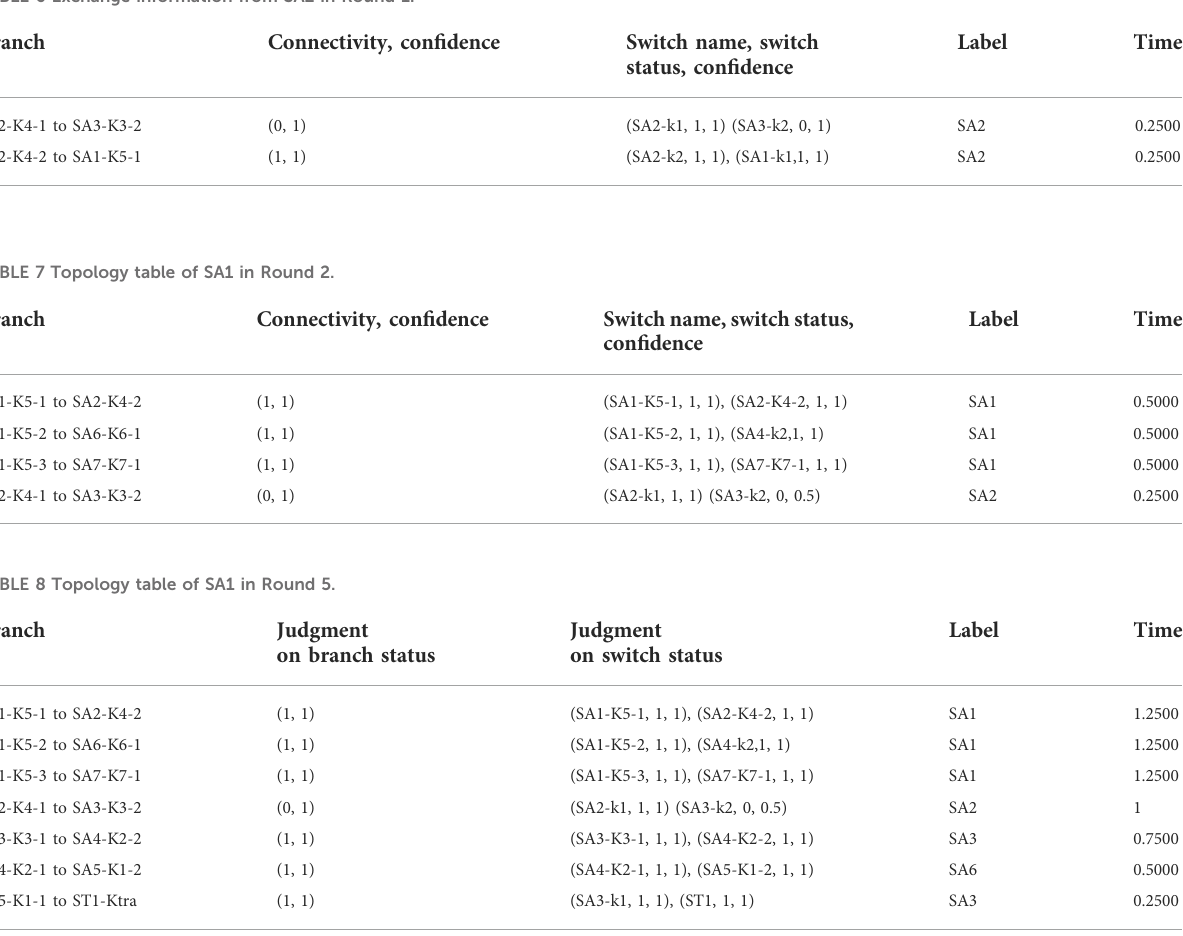
TABLE 6 Exchange information from SA2 in Round 1.